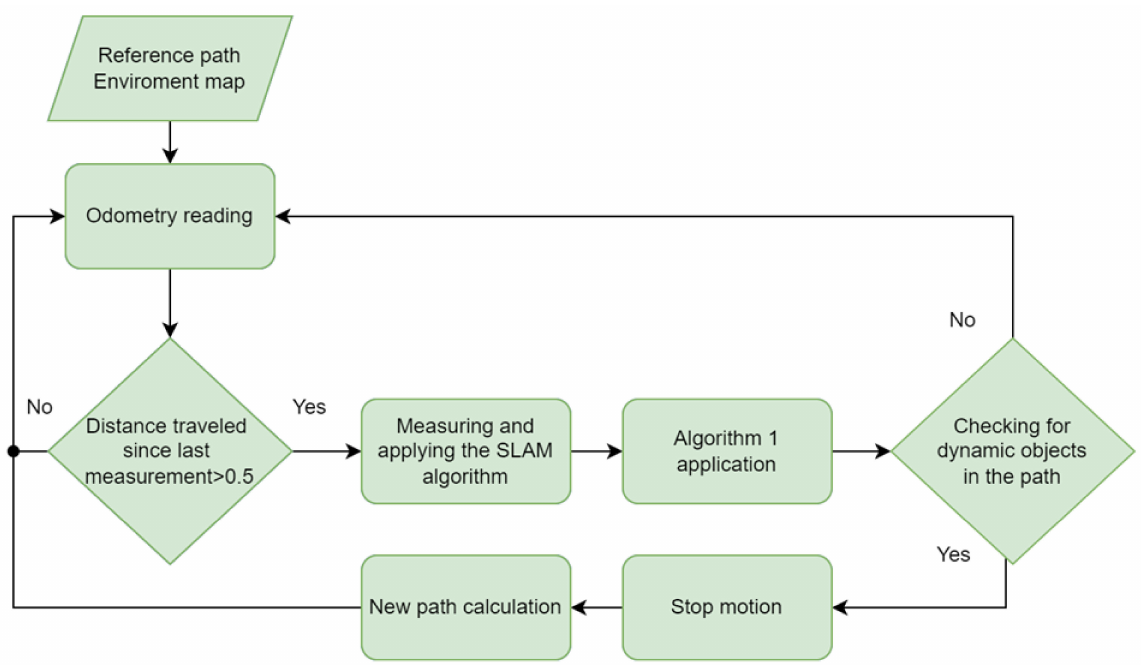
Figure 19. Flowchart for detecting dynamic objects during ASLAM